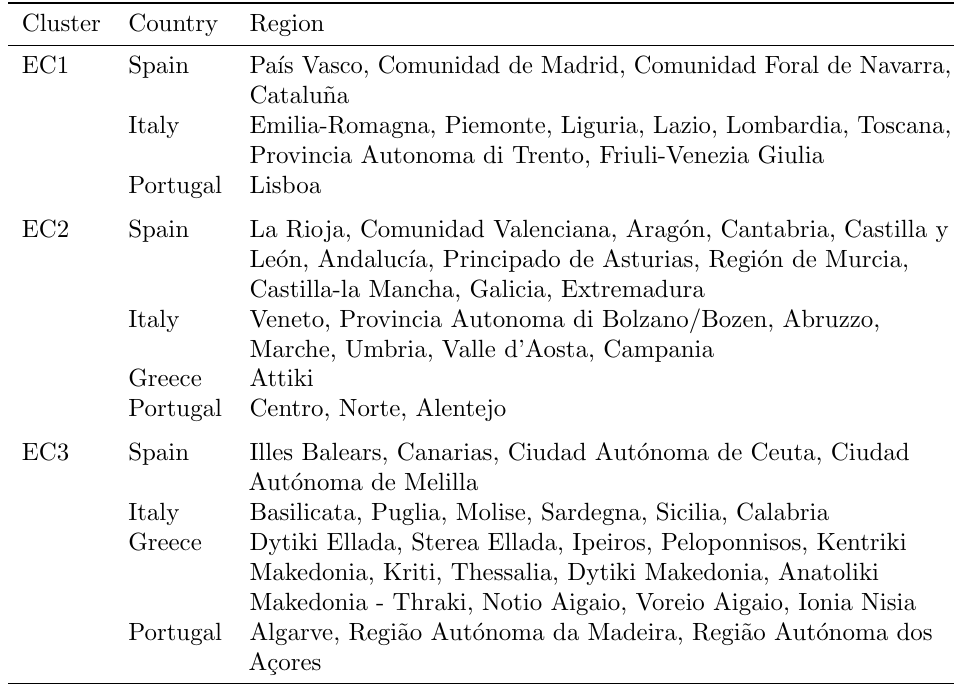
Table A.3: Clustering based on the economic characteristics of the south European regions Cluster